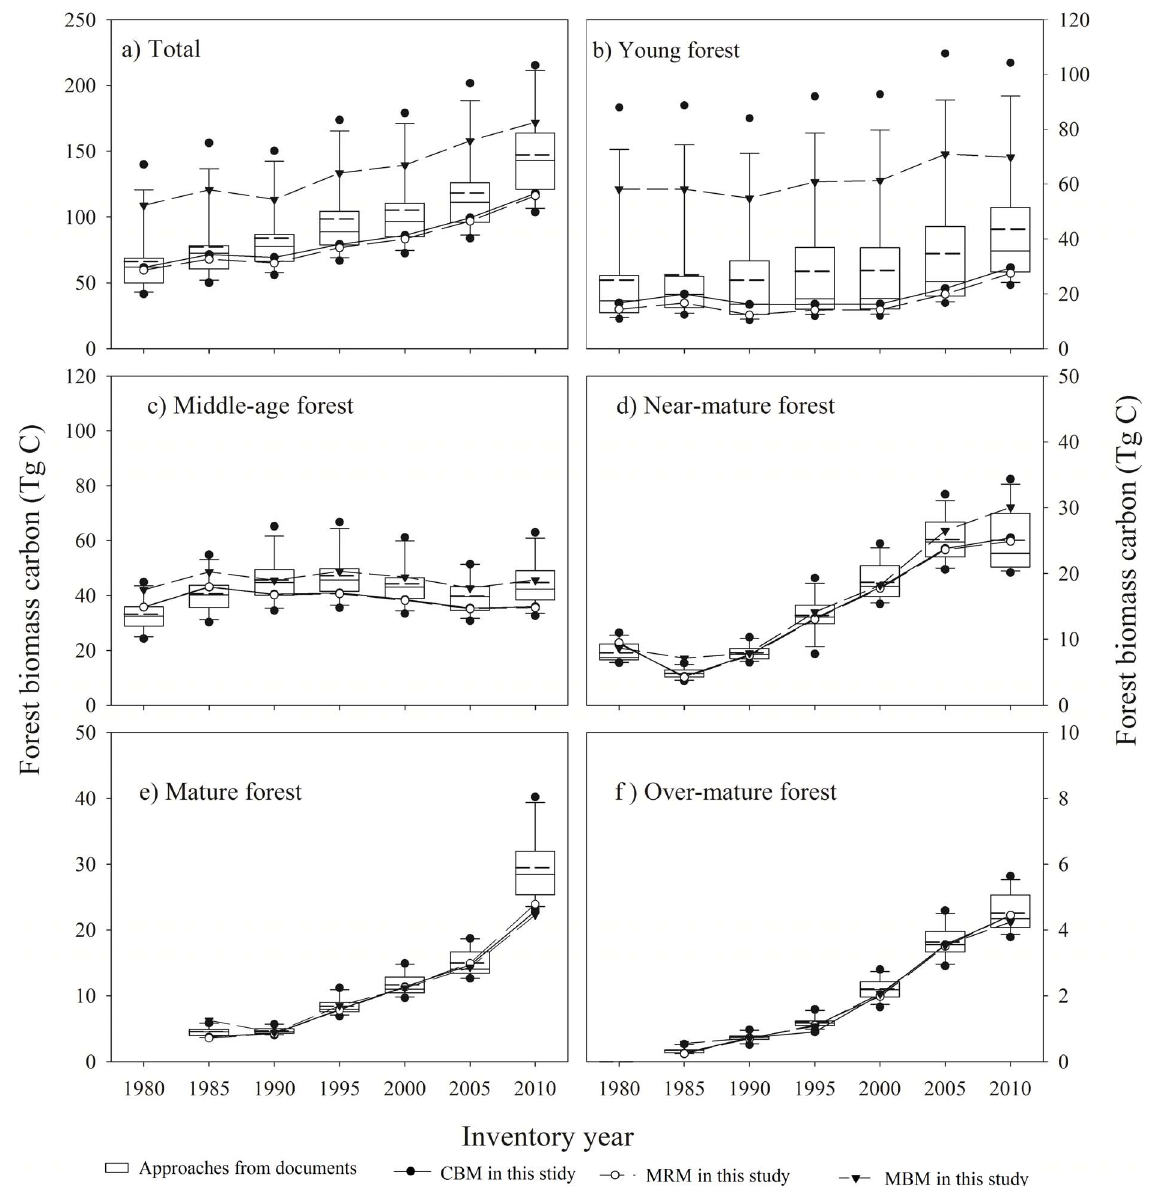
Figure 4. Mean estimates of forest biomass carbon storage in Liaoning province from 1980–2010, derived from 12 published approaches of calculation and approaches established in this study (The values derived from each method represent the average estimate of two approaches by forest groups and by forest groups with age class). The median, 10th, 25th, 75th, and 90th percentiles of estimate from 12 published approaches were plotted as vertical boxes with error bars; the dash lines in the boxes are their average. The top and bottom point (solid circle) are minimum and maximum estimates. MBM: mean biomass density method CBM: continuous biomass expansion factor method; MRM: mean ratio